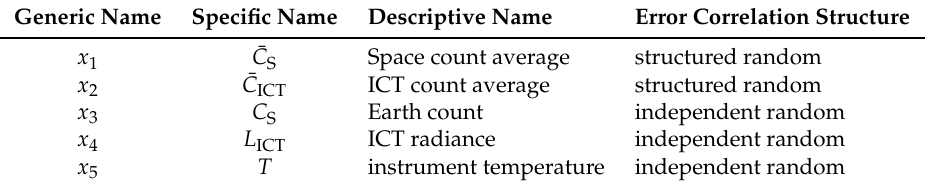
Table 1. Nomenclature and error correlation structure of AVHRR telemetry data that has been taken into